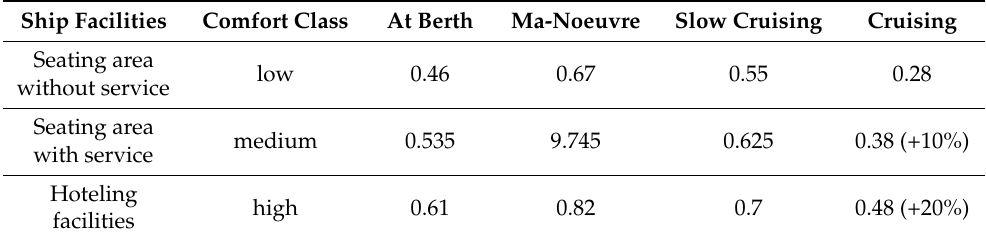
Table A2. Ship comfort class classification and resulting auxiliary engine load factors in different states of operation.